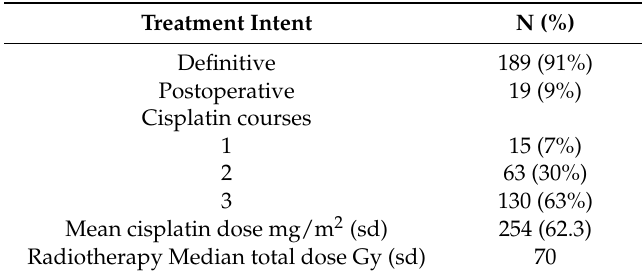
Table 2. Treatment characteristics (High Dose CCRT N =